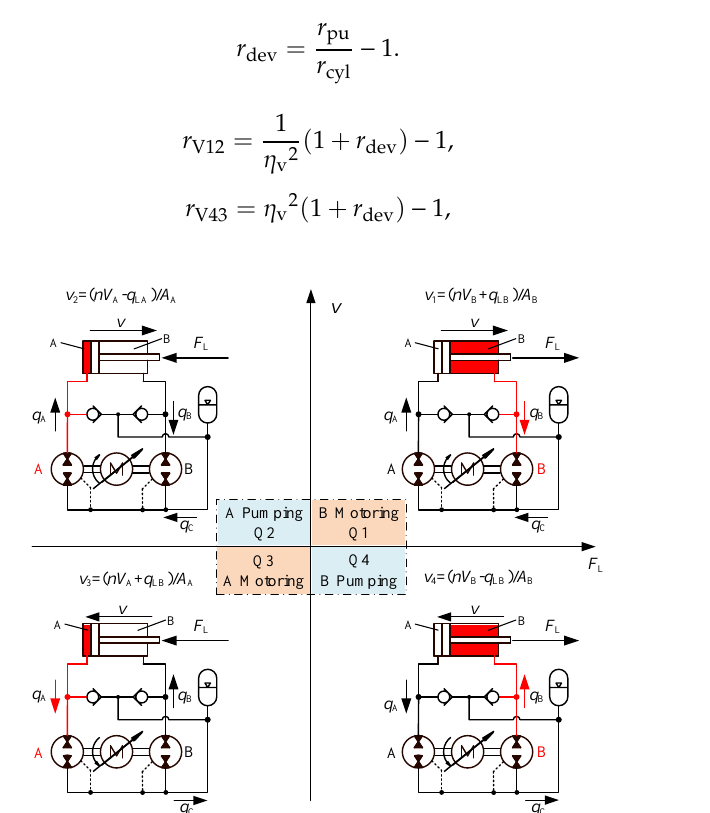
Figure 3. Four-quadrant operation of the DPC.